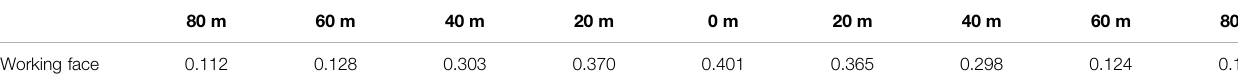
TABLE 5 | Statistical table of attenuation rate of overpressure peak at every 20 m in working face.